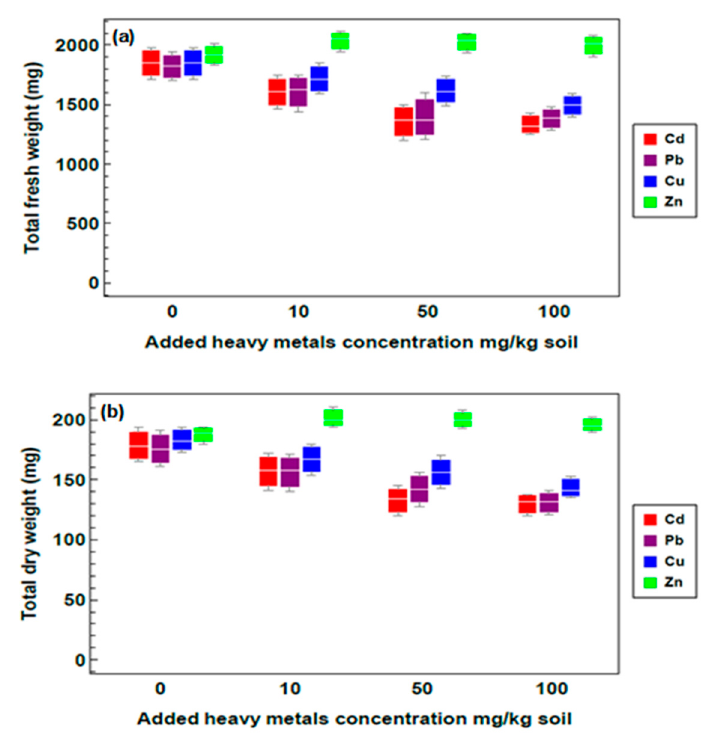
Figure 1. Growth rate of R. stricta plants exposed to di ff erent heavy metal treatments. ( a ) Fresh weight, and ( b ) dry weight of R. stricta plants samples under di ff erent treatments (means ± standard errors ( n = 5) for di ff erent heavy metal